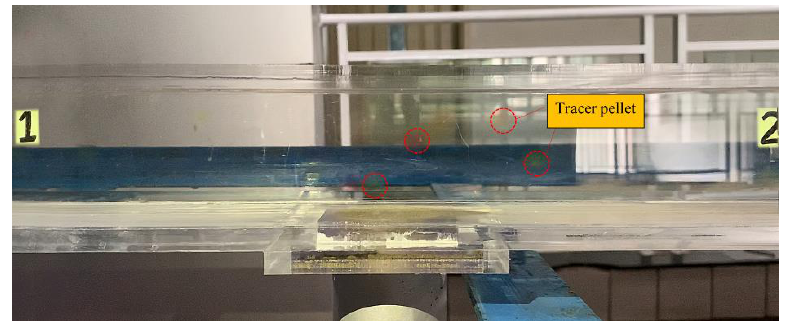
Figure 7. Velocity measurement by the tracer